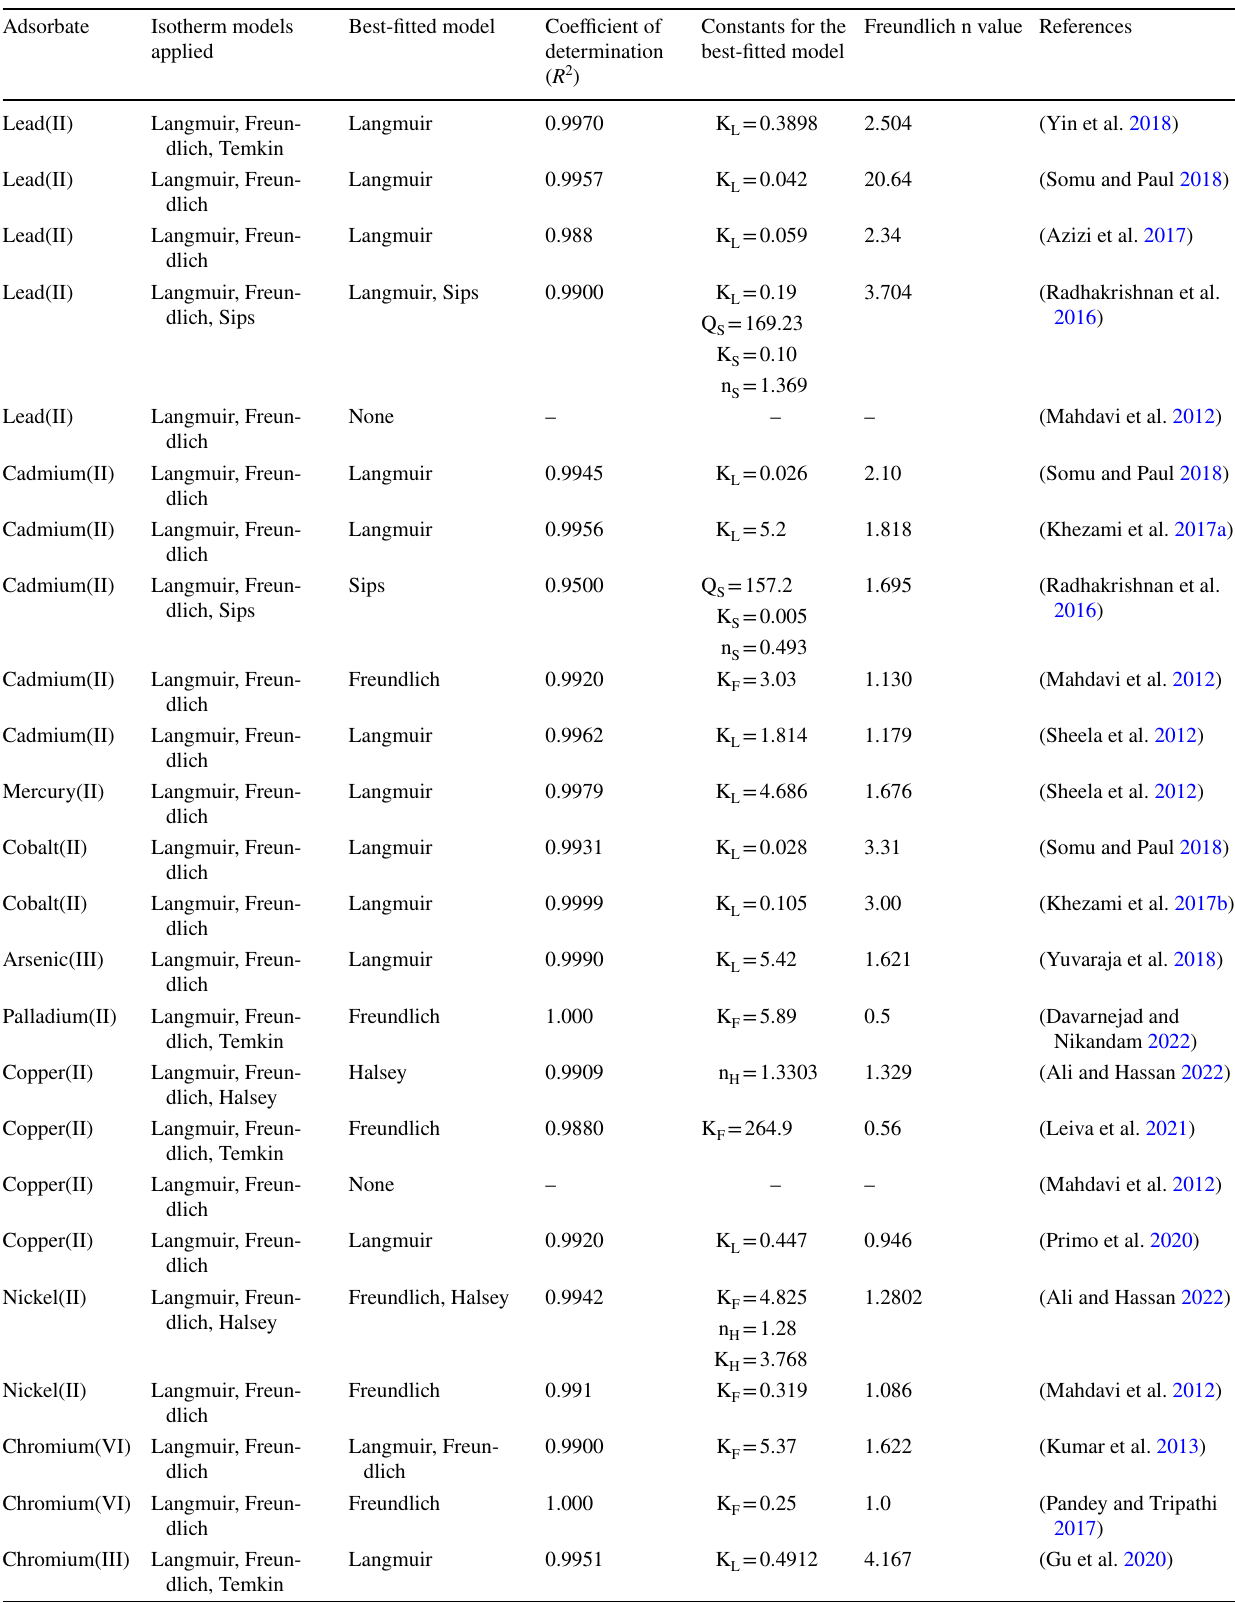
Table 3 The isotherm modeling of heavy metals and radionuclides adsorption onto ZnO nanoparticles